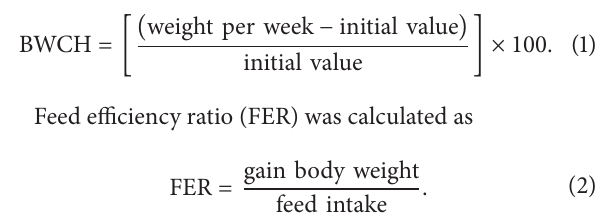
Figure 1: Trends of body weight. Values represent mean ( 𝑛 = 10 ). C: control group; HFD: high fat diet group; LPH: HFD + Lactobacillus plantarum LS/07; LPP: HFD + Lactobacillus plantarum Biocenol